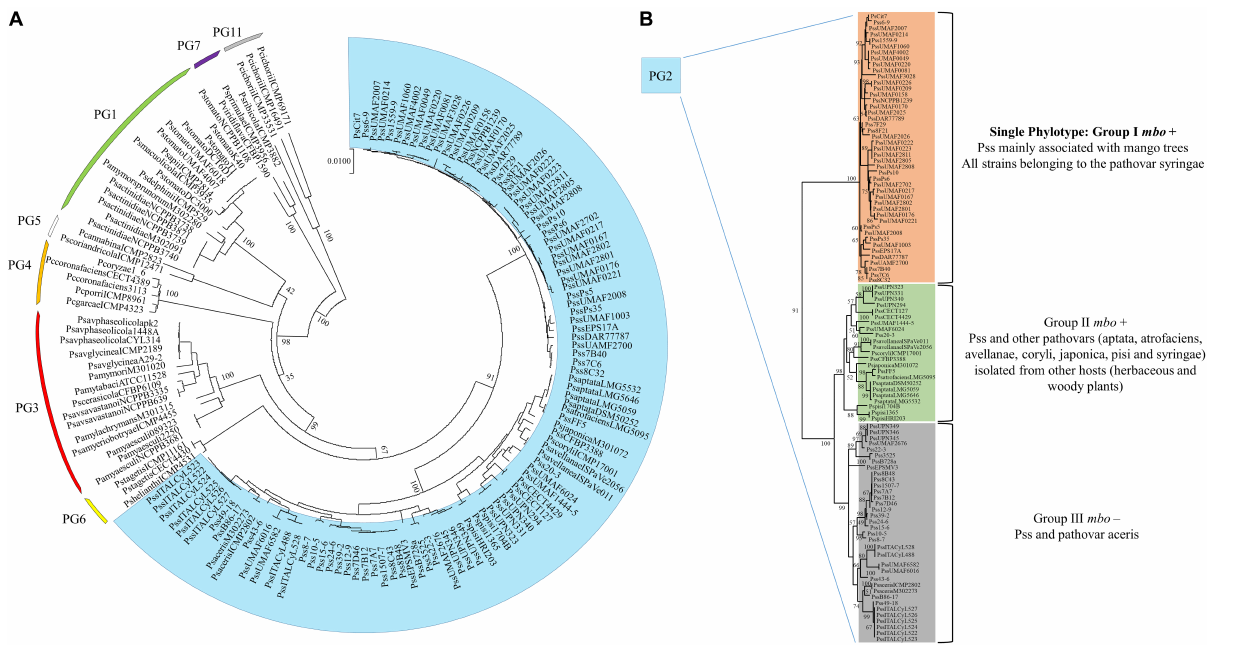
Frontiers in Plant Science |